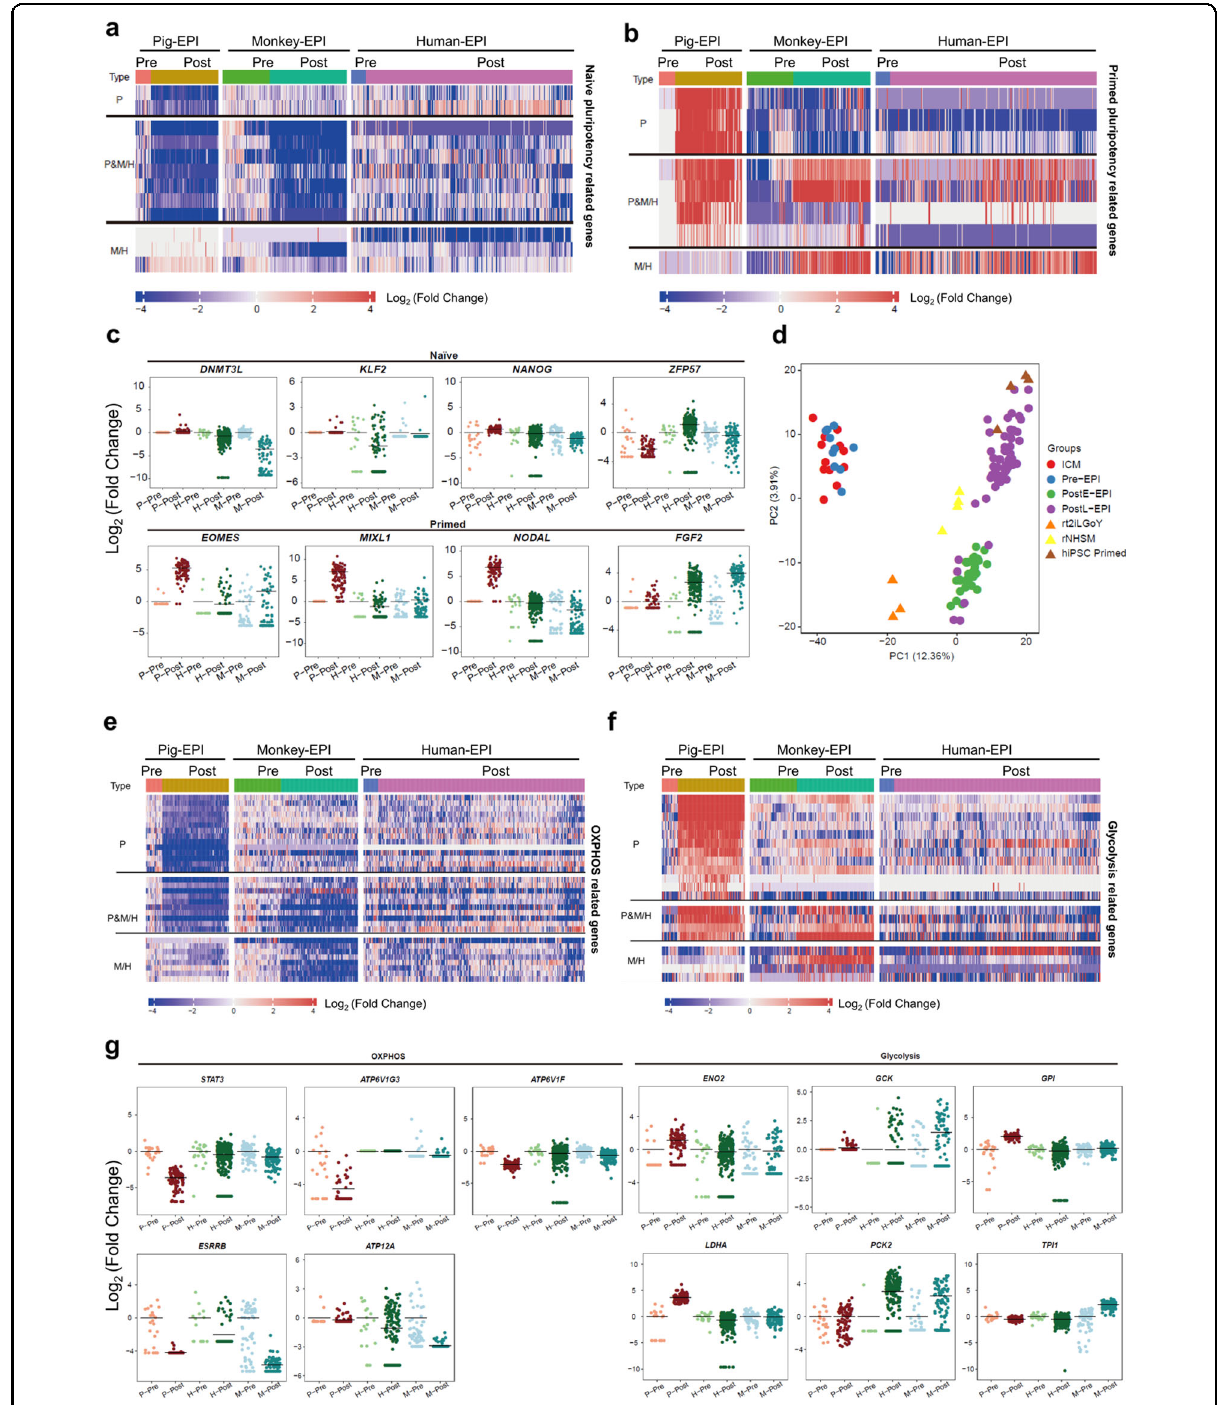
Fig. 4 Cross-species comparison of metabolic, epigenetic, and transcriptional regulations of pluripotency among pig, monkey, and human EPIs. a Heatmap of naïve-related genes in Pre- and Post-EPIs in pigs, humans, and monkeys. b Heatmap of primed pluripotency-related genes in Pre- and Post-EPIs in pigs, humans, and monkeys. c Scatter-plot of species-speci fi c naïve and primed pluripotency-related genes. P-Pre, pig ICM and Pre- EPIs; P-Post, pig PostE- and PostL-EPIs; H-Pre, human D6-EPIs; H-Post, human D8- and D10-EPIs; M-Pre, monkey ICM and Pre-EPIs; M-Post, monkey PostE- and PostL-EPIs. Using Pre-EPIs as a control, fold change of gene expression in each cell relative to the average expression level in Pre-EPIs was calculated. d PCA of pig EPIs and human iPSCs. e Heatmap of OXPHOS-related genes in Pre- and Post-EPIs in pigs, humans, and monkeys. f Heatmap of glycolysis-related genes in Pre- and Post-EPIs in pigs, humans, and monkeys. g Scatter-plot of species-speci fi c OXPHOS- and glycolysis-related genes. Stage information was indicated as follows: Pre-, Day 5 or/and Day 7; PreE-, Day 5; PreL-, Day 7; Post-, Day 10 and Day 12; PostE-, Day 10; PostL-, Day 12. The horizontal lines in c and g indicate the mean values. To avoid the in fl uence caused by the “ 0 ” value, a new matrix was generated by using FPKM + 1 and the log 2 -transformed fold change was